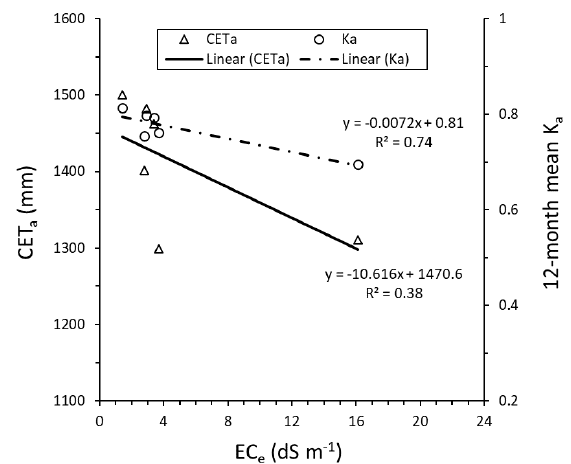
Figure 13. The relationship of cumulative actual evapotranspiration (CET a ) and mean annual actual crop coefficient (K a ) versus electrical conductivity of the saturation extract (EC e ). The average EC e of the entire soil profile (1.2 m depth) from the whole soil samples at each date palm site were used to represent the average EC e of crop root zone in each of the experimental sites.